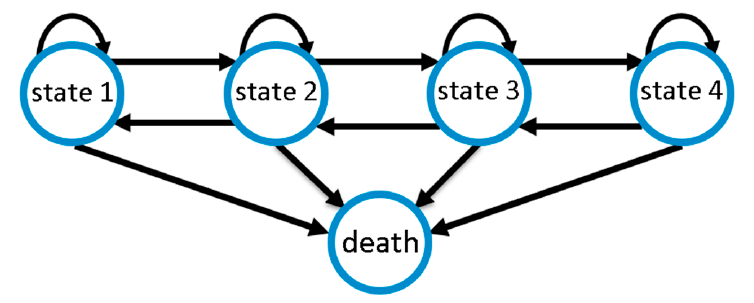
Figure 2. Markov model of community-acquired pneumonia (CAP) disease course with four disease states of increasing severity and death as absorbing state. Disease ameliorations and deteriorations occur stepwise, while death is possible at any state.